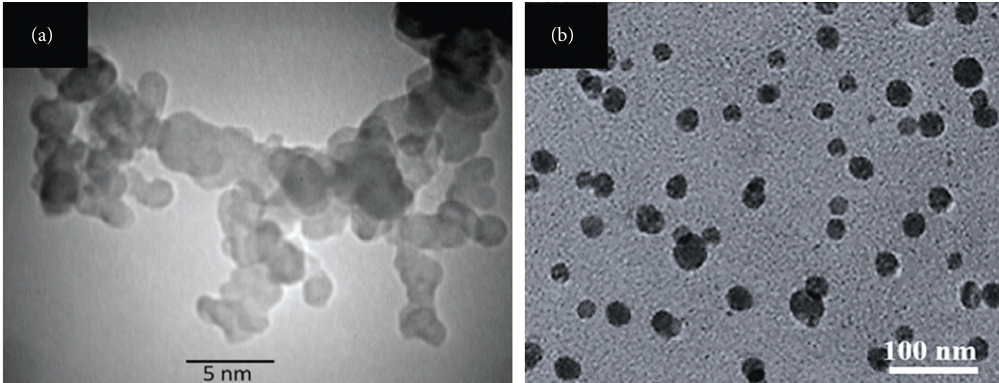
Figure 7: TEM images of (a) Al 2 O 3 NPs [150] and (b) Cr 2 O 3 NPs